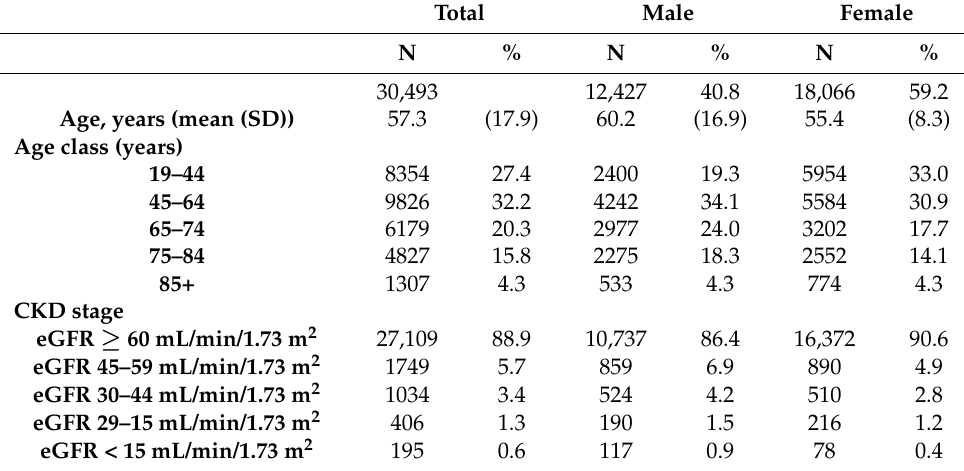
Table 1. Distribution of Chronic Kidney Disease CKD stages based on the CKD-EPI equation *, by sex. Total Male Female N % N % N %